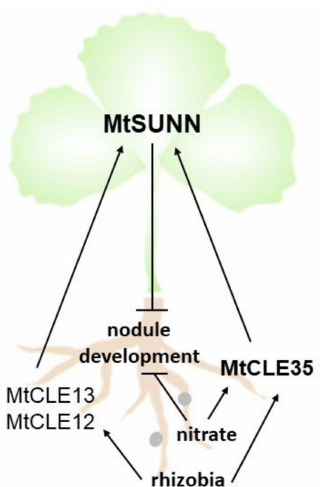
Figure 7. Model of MtCLE35 action in autoregulation of nodulation (AON). The MtCLE12 and MtCLE13 genes are induced in response to rhizobia inoculation, whereas the expression of the MtCLE35 gene is induced by both rhizobia inoculation and nitrate treatment. The CLAVATA3 / ENDOSPERM SURROUNDING REGION-related (CLE) peptides encoded by the MtCLE12, MtCLE13, and MtCLE35 genes systemically inhibit nodulation via shoot-acting MtSUNN receptor kinase. MtCLE35 mediates nitrate-dependent inhibition of